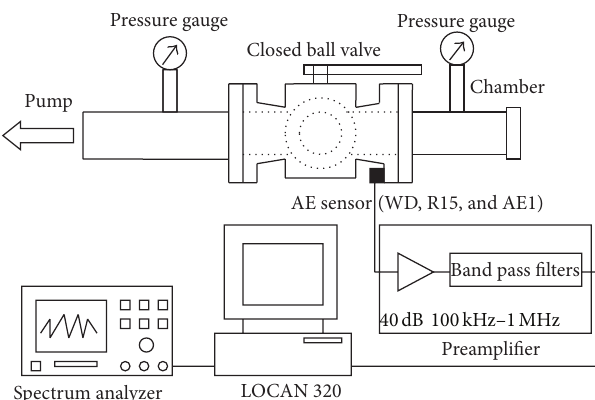
Figure 2: Diagram of experimental setup